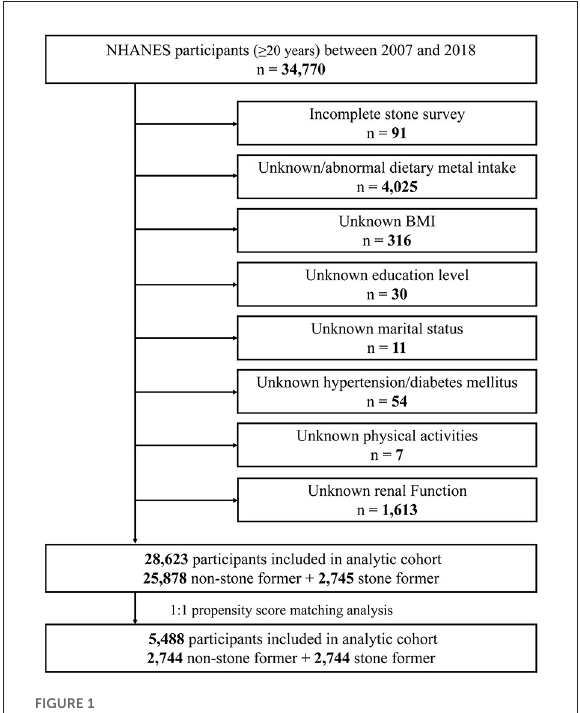
FIGURE1 Schematic overview for patient